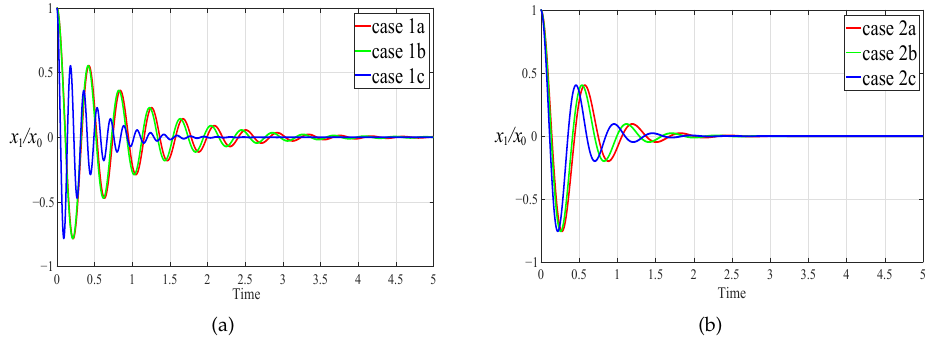
Figure 5. Transient response to initial displacement x 0 : ( a ) α 1 > 0. ( b ) α 1 <